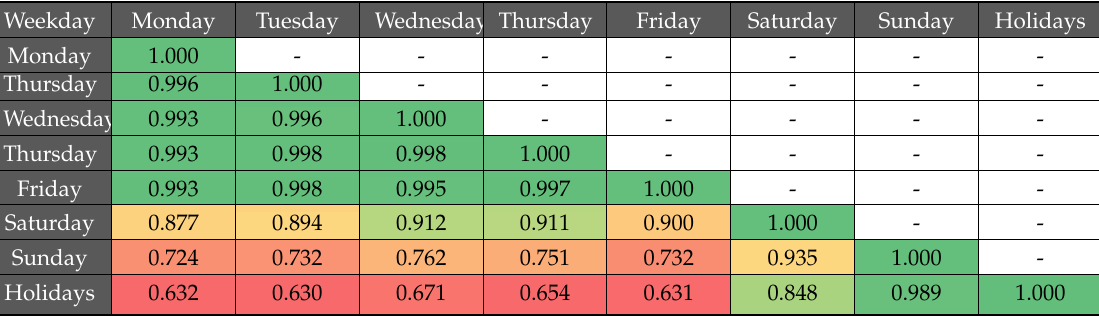
Table 2. Hourly correlation matrix between days in